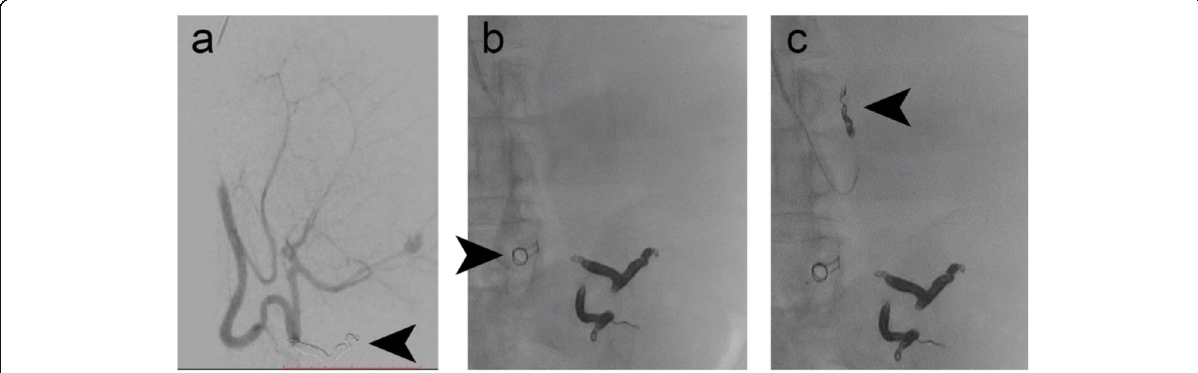
Fig. 7 Case 8. a Pre-embolisation DSA imaging of the splenic artery. The arrow indicates the result of a prior coil embolisation procedure. b An 8 mm diameter shape memory polymer plug was deployed into the 8 mm diameter splenic artery (arrow indicates the anchor coil) after distal packing with gelatin sponge and PVA particles. c Microcoil embolisation of another branch completed the case, prior to splenectomy to treat